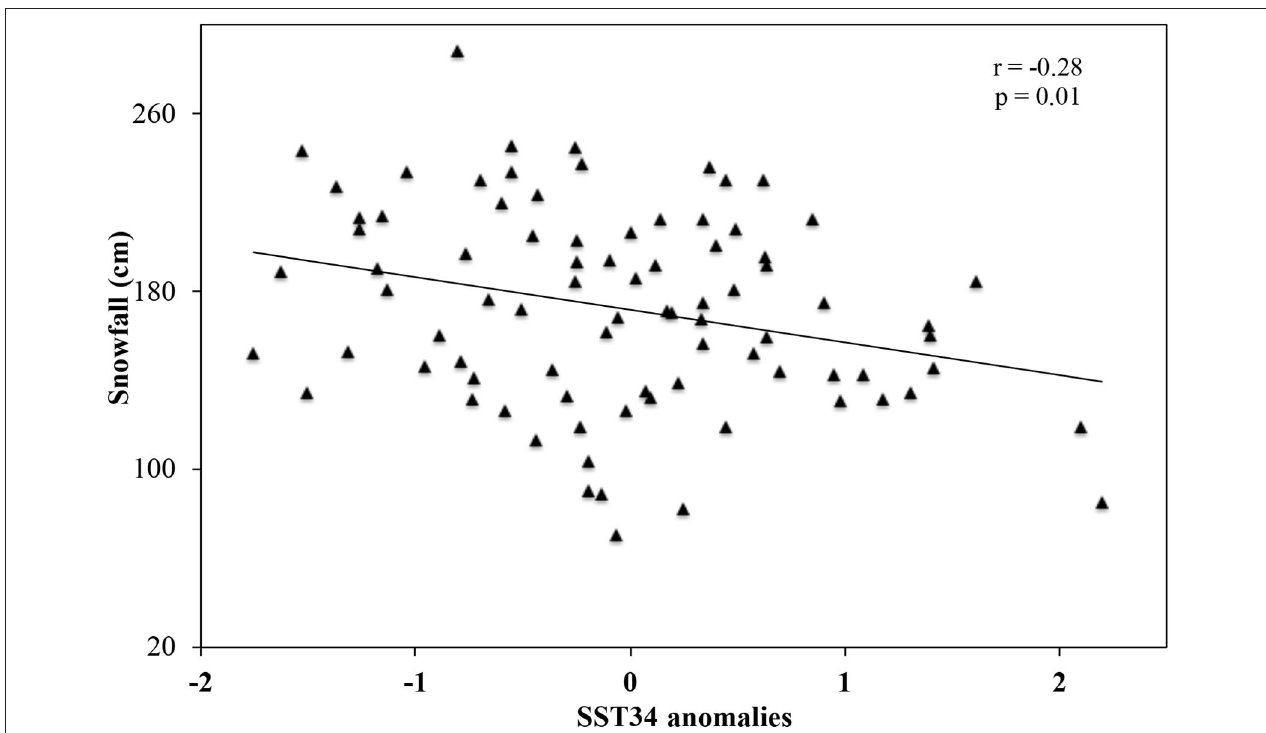
FIGURE 5 | Scatter plot of average annual total snowfall over the eight stations vs. SST34 anomalies. A Pearson correlation coefficient ( r ) and p -value are shown on the figure.